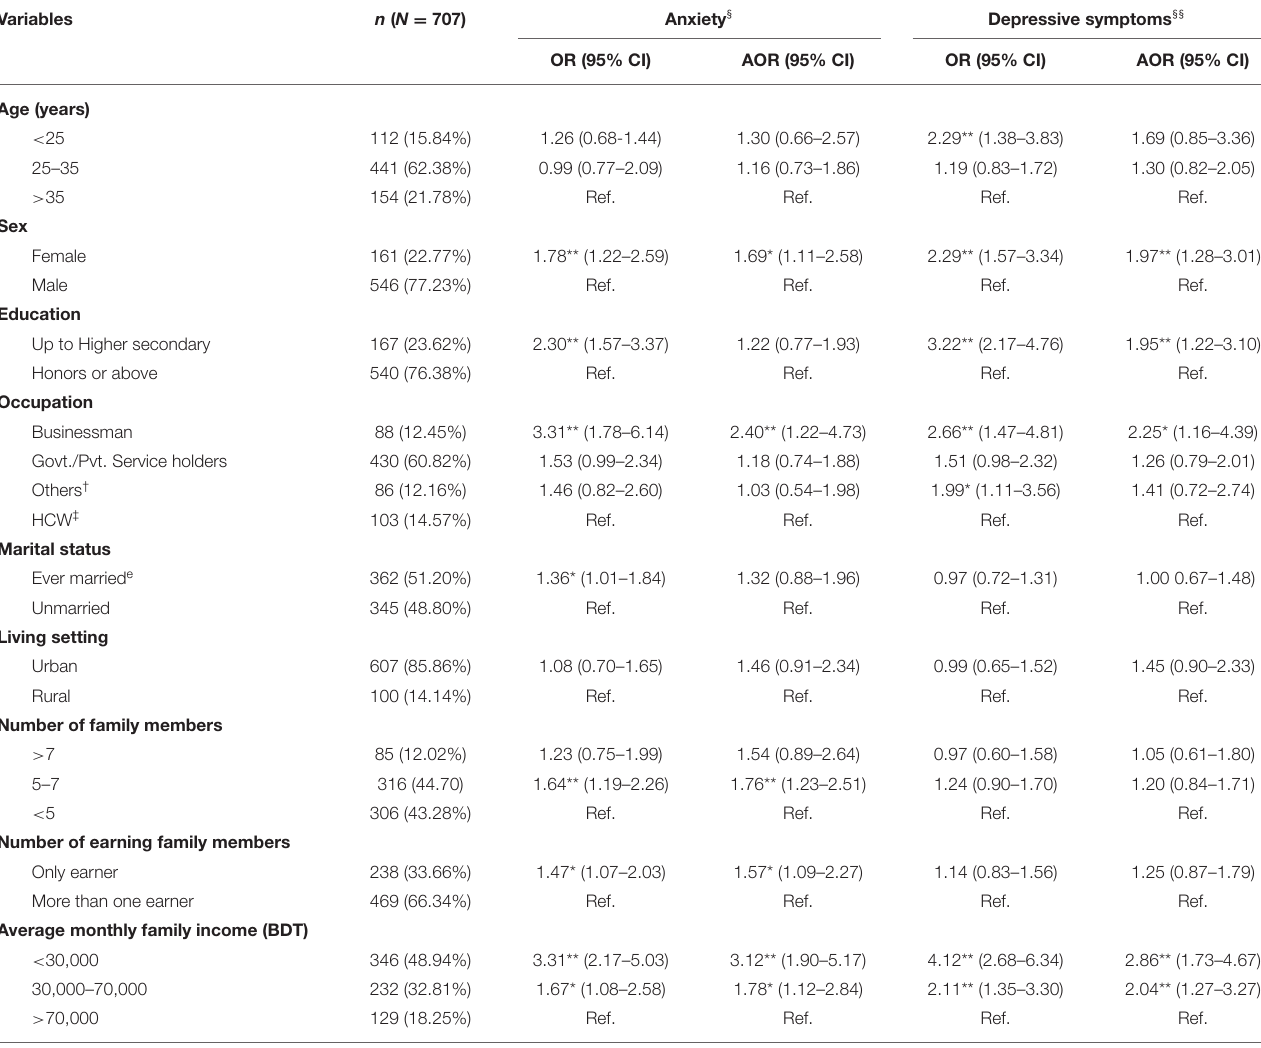
TABLE 1 | Association among socio-demographics, anxiety and depressive symptoms among adult wage earners in Bangladesh. Variables n ( N = 707) Anxiety § Depressive symptoms